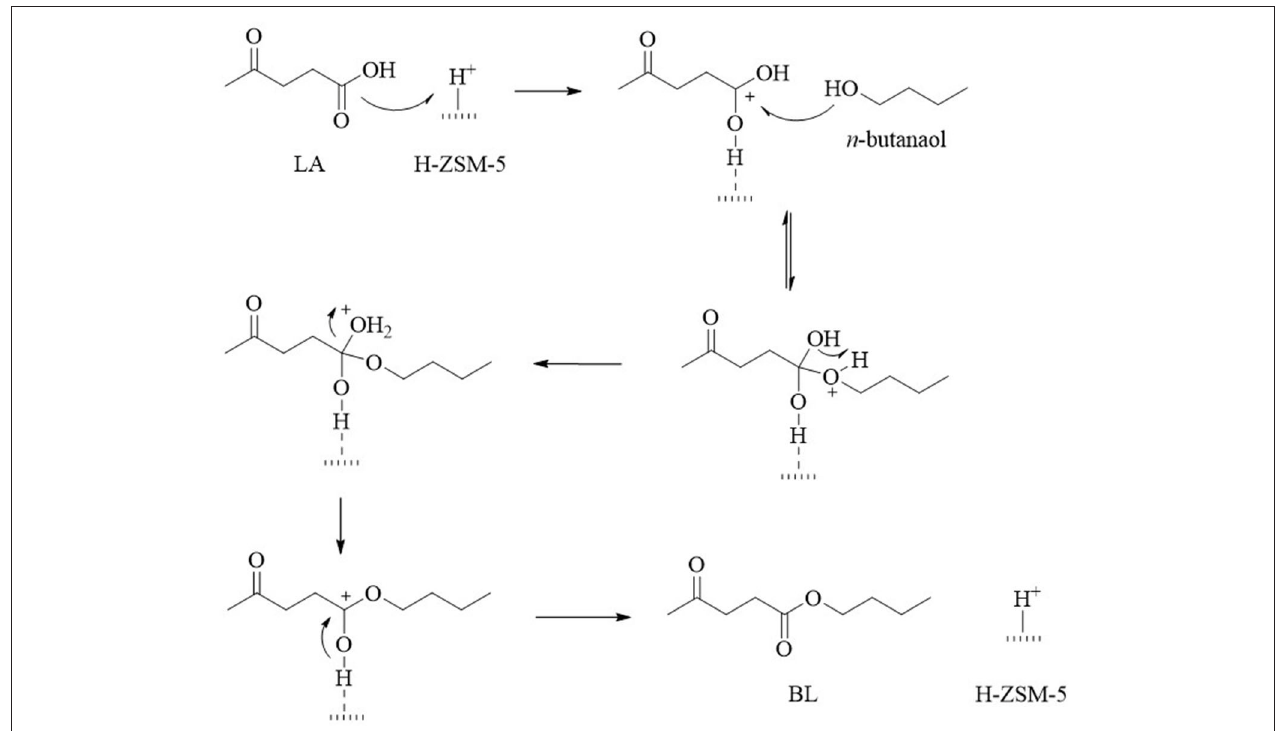
FIGURE 2 | Proposed reaction mechanism for the esterification of LA with n -butanol over the H-ZSM-5 catalyst.